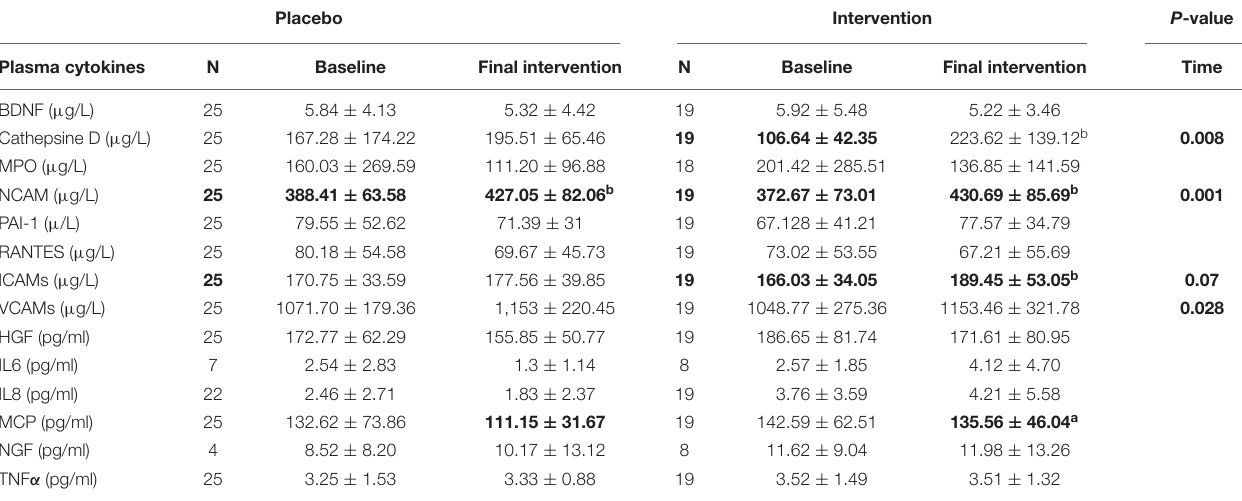
TABLE 5 | Plasma cytokines levels in children with ASDs at baseline and after 6 months with DHA intervention or placebo. Placebo Intervention P -value Plasma cytokines N Baseline Final intervention